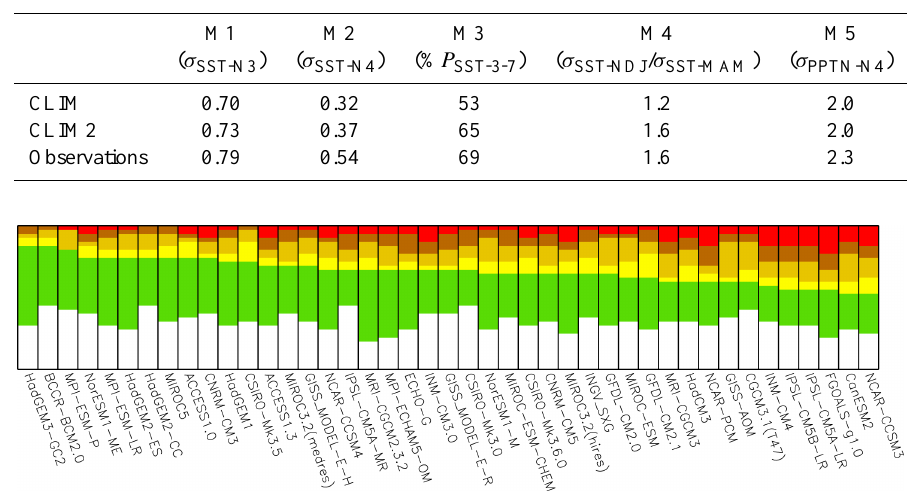
Figure 16. Proportion of teleconnections to Africa in each of the five skill categories (details in Rowell, 2013). Green: at least reasonable model skill; yellow: marginal skill; pale brown: moderate and significant difference between model and observed teleconnection strength, dark brown and red: poor or very poor skill; and white: SST-rainfall associations of little practical interest. CMIP3 and CMIP5 models, together with HadGEM3-GC2 CLIM experiment, are ranked by the number of teleconnections that do not differ significantly from those observed at the 10%